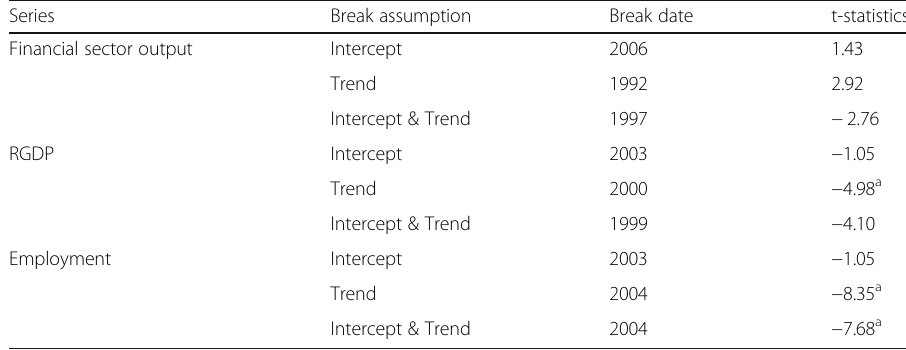
Table 2 Zivot-Andrews Structural break